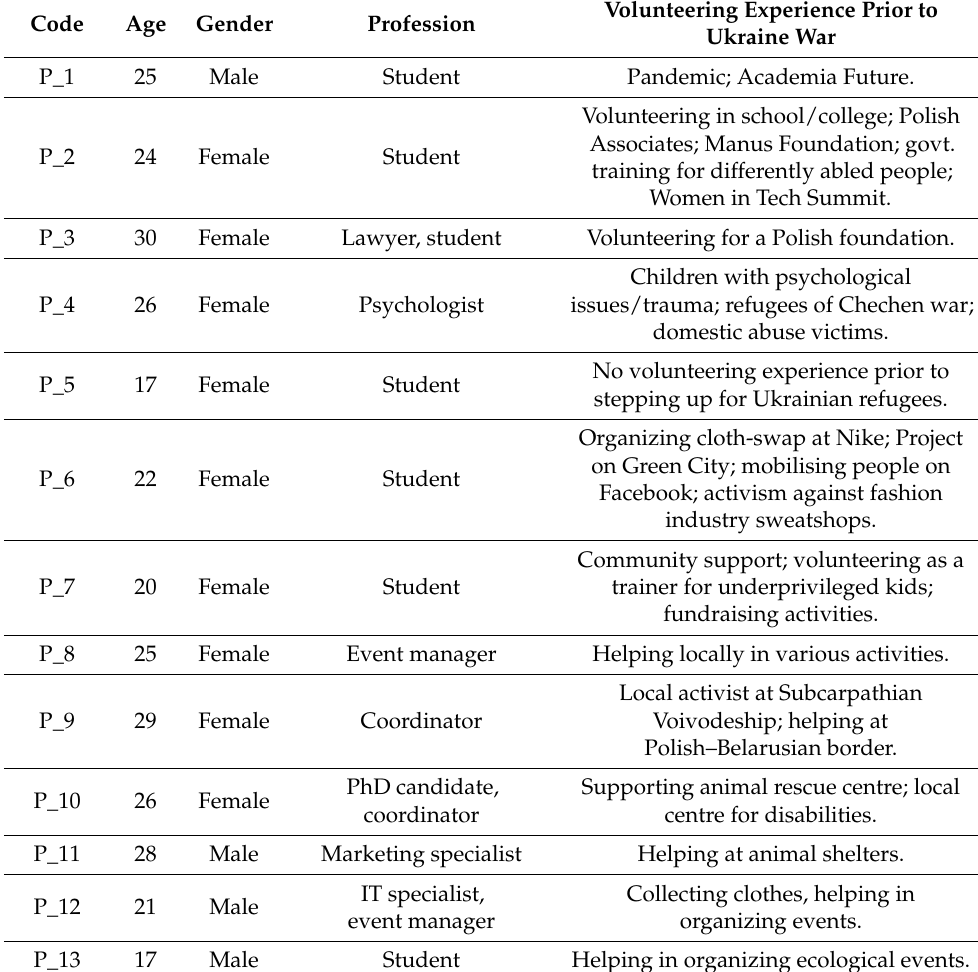
Table 1. Participant